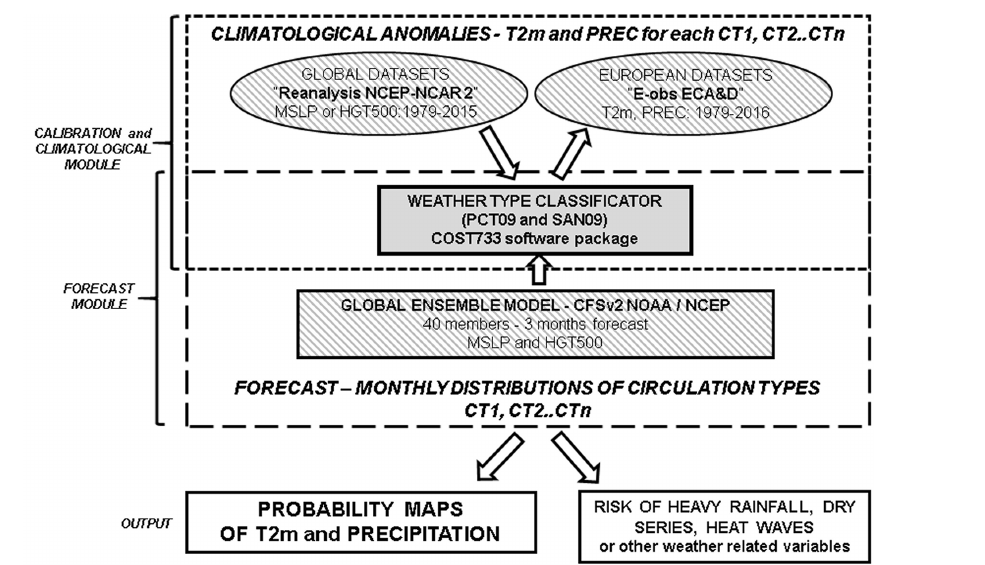
Figure 1. Diagram of the proposed framework for seasonal forecasts.